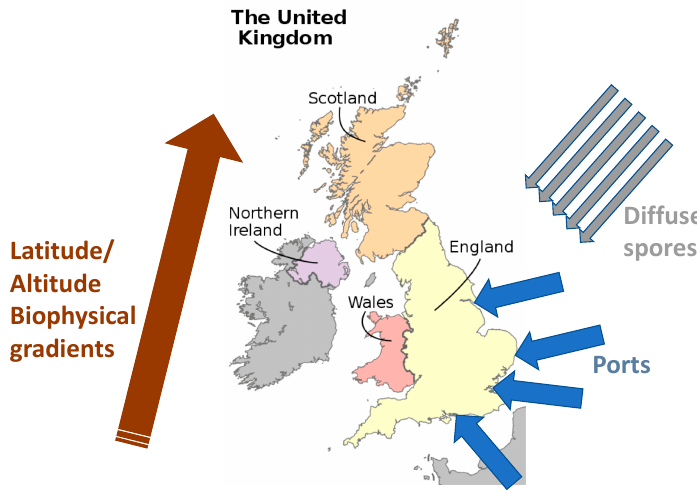
Figure 1. Perspectives on ‘the border’ for early detection of tree pests and pathogens as provided by scientists early within the study.